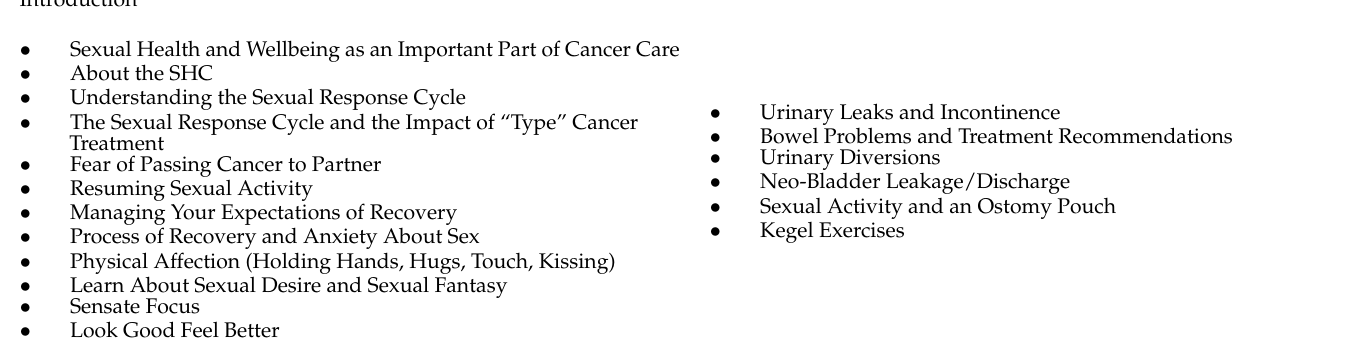
Table 1. SHC Educational